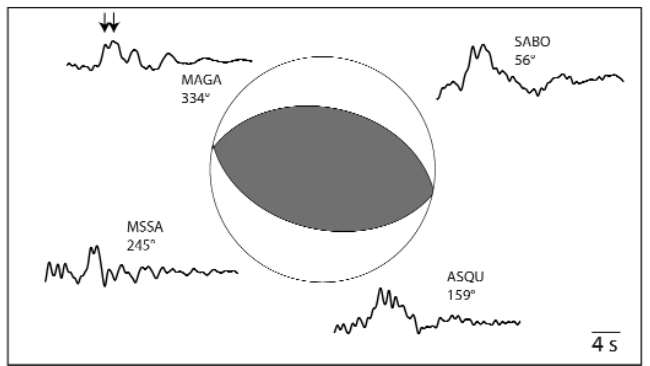
Figure 4. Relative source time functions calculated through EGF decon- volution for the May 20, 2012, M 5.9 earthquake. Arrows, the two pri- W mary pulses that appear to correspond to the correlation peaks shown by the ZLCC maps of Figures 2 and